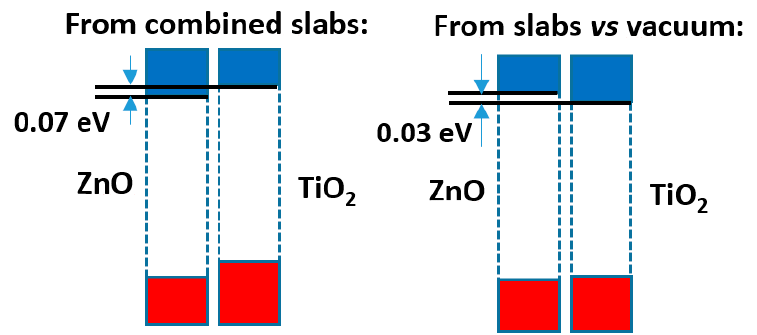
It is worthwhile trying to understand this difference between both models. One way could be to examine the Hartree potential profile for the alternating slabs model and obtain the difference between it and the sum of the Hartree profiles of the individual slabs, while keeping the same cell size and atomic positions. The difference, shown in Figure 5, is not large, it is certainly much smaller than the values of the full profile shown in Figure 3; but one finds that the Hartree potential imbalance between one phase and the other shown in Figure 5 (0.33 eV) is clearly higher than the difference in results between both models (just 0.1 eV). Some other effects must be at work. Very probably the reason is that while in the slabs versus vacuum model there will be a spill of electronic density towards the vacuum side which may reach different distances in the ZnO and TiO 2 cases (and note that this will appear as well in the alternating slabs model, with fixed atomic positions involved in the said subtraction of Hartree potential profiles), this is not possible in the alternating slabs case, where in addition the Pauli exclusion principle will force a rear- rangement of the individual wavefunctions. The mentioned Hartree potential difference is thus not useful to understand the difference between both methods of estimating the band offset. In the following, this difference of Hartree potential will not be considered further. Figure 5. Difference between the Hartree potential profile of the alternating slabs model (for the ZnO|anatase TiO 2 interface) and the sum of the two individual slabs facing vacuum (with cell dimensions and atomic coordinates kept fixed). As in previous cases only one-half of the cell is shown.